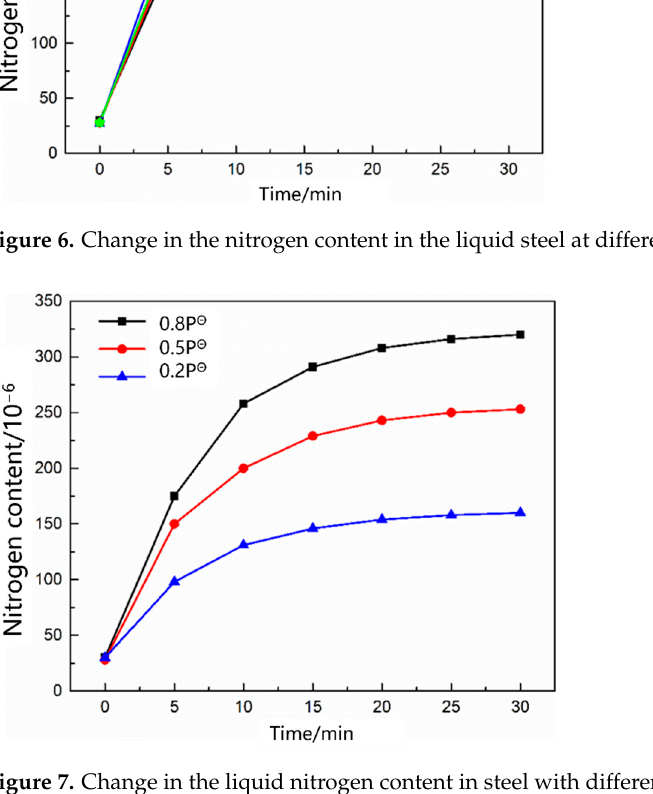
Figure 7. Change in the liquid nitrogen content in steel with different nitrogen partial pressures. Equation (6) is integrated to obtain Equation (7),